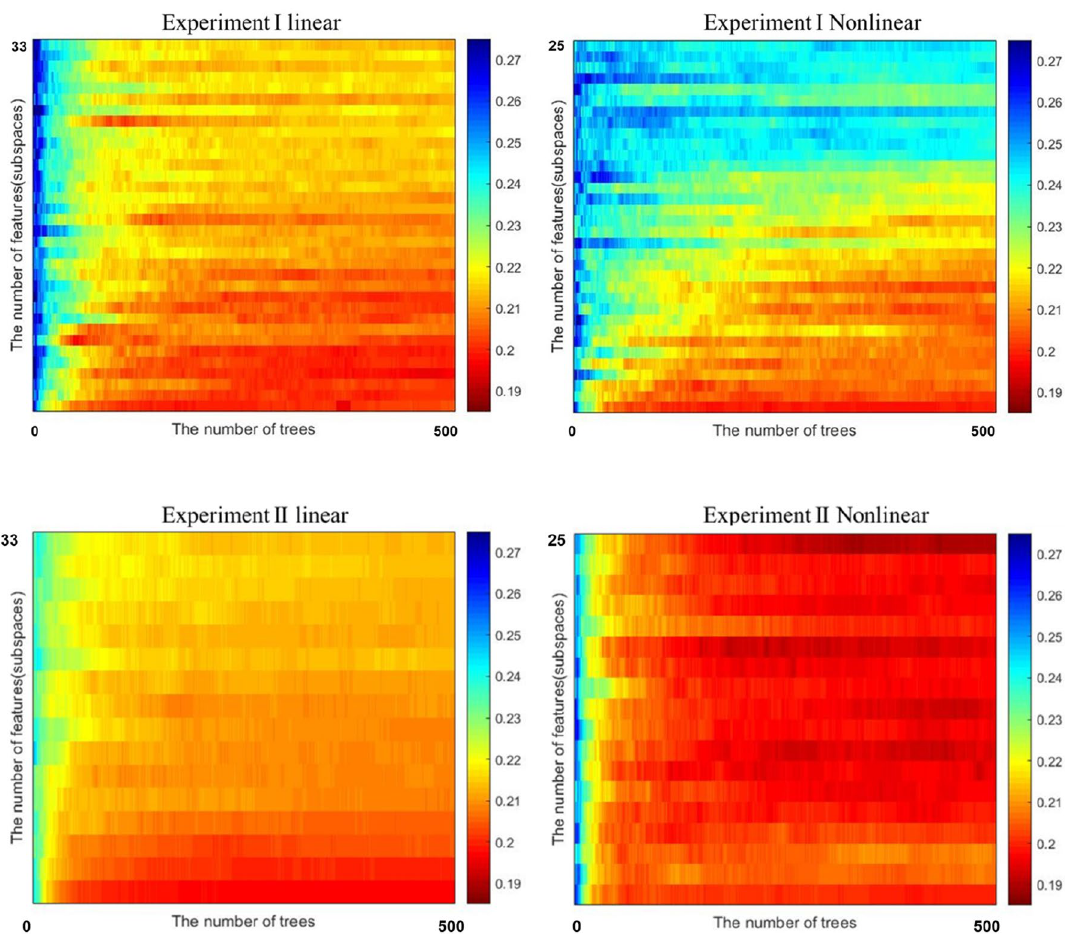
Figure 1. Heatmap of errors from Experiment I (left) and Experiment II (right). The X-axis represents number of tree (0–500) and Y-axis represents number of linear (n = 33) and nonlinear (n = 25)